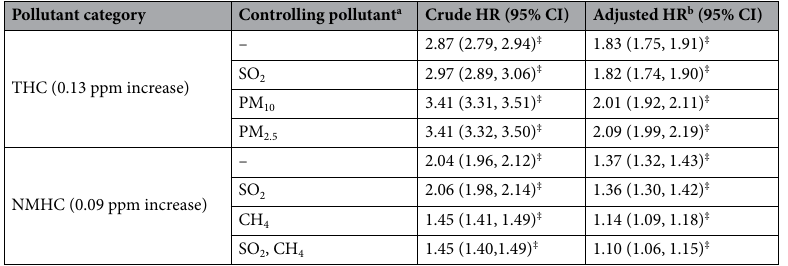
Table 3. Crude and adjusted hazard ratios of developing urinary bladder cancer during long-term THC or NMHC air pollutants exposure at a standard deviation (SD) increment controlled for PM 2.5 and other air pollutants. HR hazard ratio, CI confidence interval, SO 2 sulfur dioxide, PM 10 particulate matter < 10 μm in size, PM 2.5 particulate matter < 2.5 μm in size, CH 4 methane. a Additional pollutants were added into the pollutant models for multiple analysis only when Pearson’s correlation coefficient was < 0.3. b Cox regression models were adjusted for age, sex, level of urbanization, the black-foot disease endemic region, essential hypertension, chronic cystitis, smoking-related diagnoses, alcohol use disorders, morbid obesity, spinal cord injury, chronic liver disease, diabetes mellitus, gout, chronic kidney disease, pesticide exposures, dyslipidemia, lag0–2, season, and ambient temperature, controlled pollutants (weak correlation with THC or NMHC). ‡ p < 0.001.